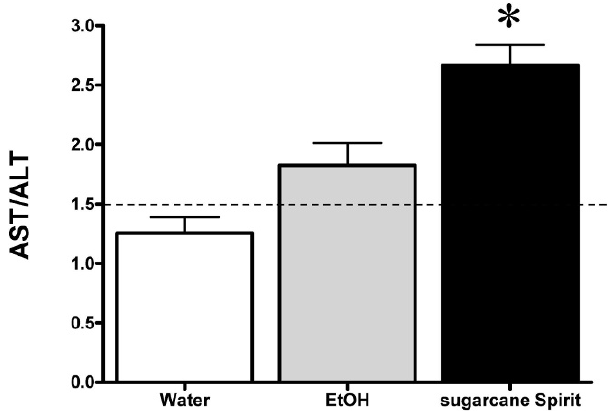
Figure 2 - Detection of liver marker enzymes . The data are presented as the mean ¡ SEM of the serum aspartate aminotransferase (AST) to alanine aminotransferase (ALT) ratio. The dashed line represents the cutoff for suggesting liver injury (AST/ALT . 1.5). * p , 0.05 compared to the controls (distilled